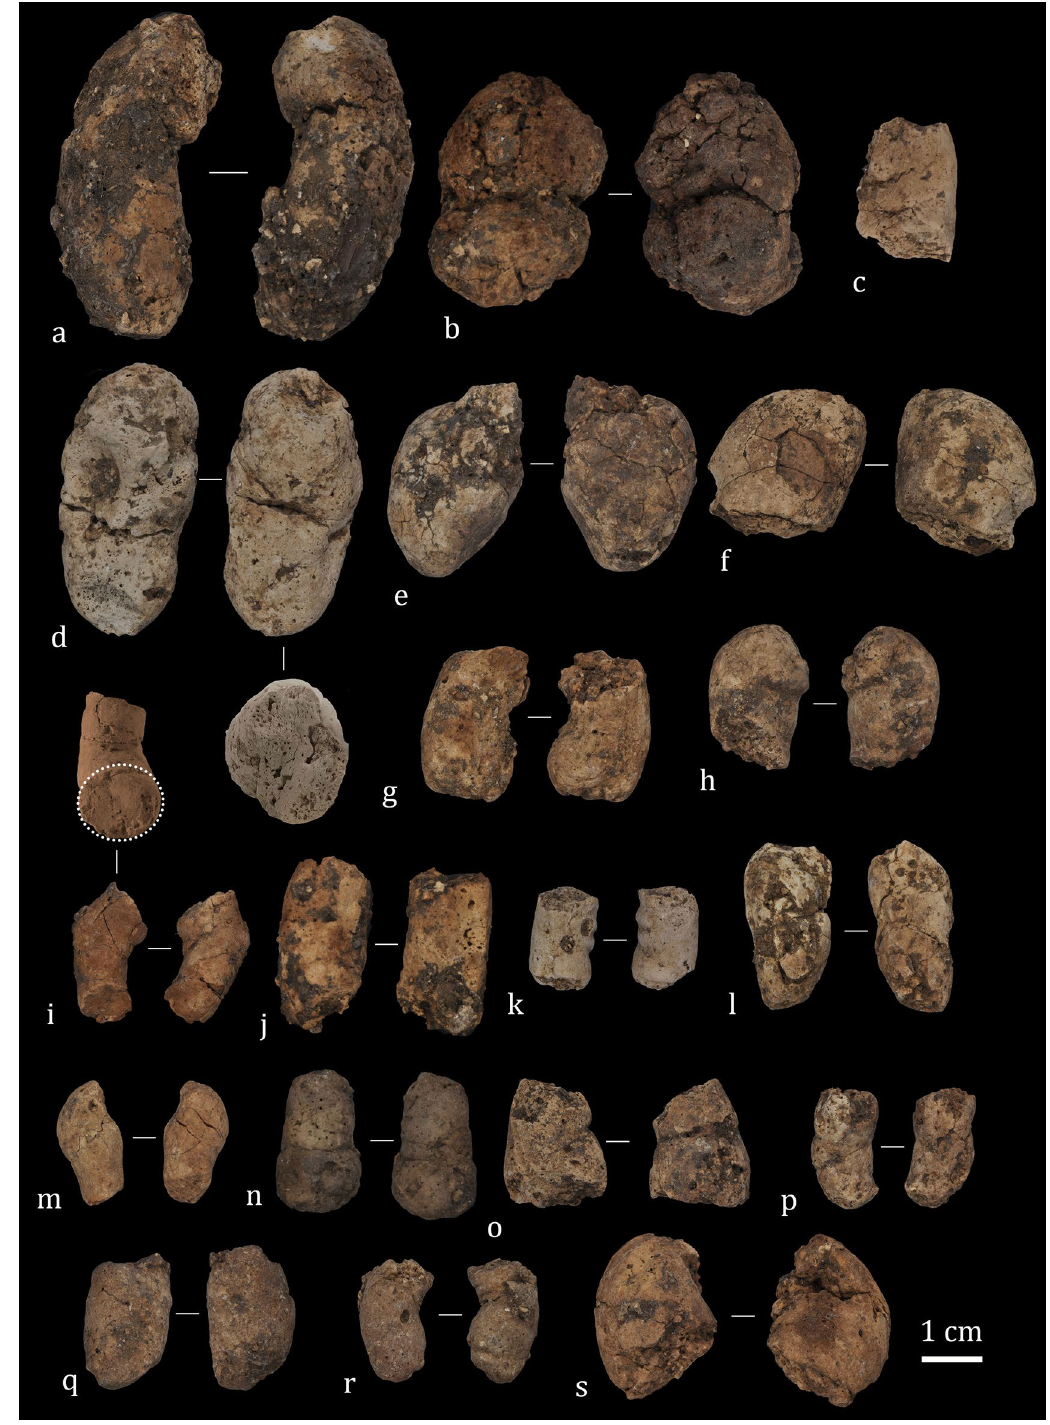
Figure 4. Coprolites recovered from ALV layer 143, highlighting their internal texture (white discontinuous circle) ( i ). Compositional characterization was performed on coprolites ( c) (sample #3) and ( d ) (sample